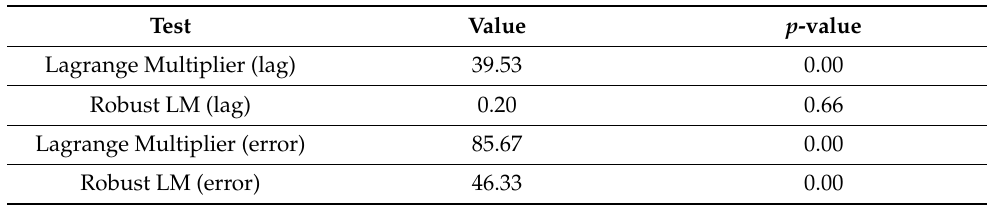
Table 4. Spatial dependence diagnosis.